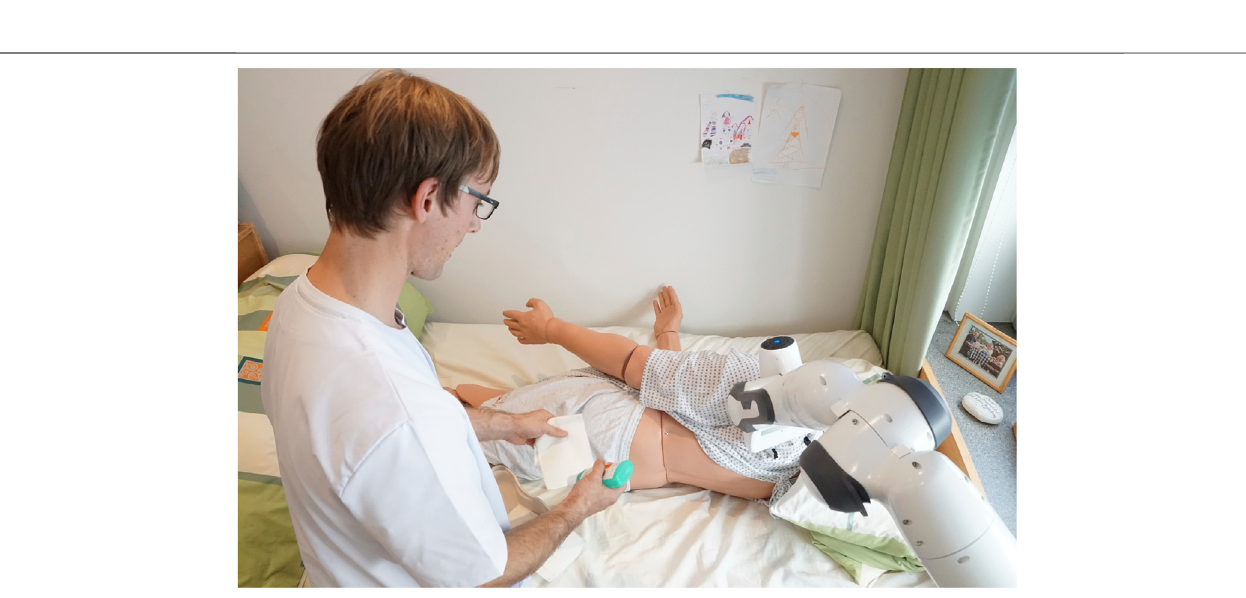
FIGURE2| Scenariowheretherobotholdsthepatientinposition,freeingbothhandsofthecaregiver,sotheycanperformthecareaction(likecleaningthepatient or healing a wound) faster and more agile.